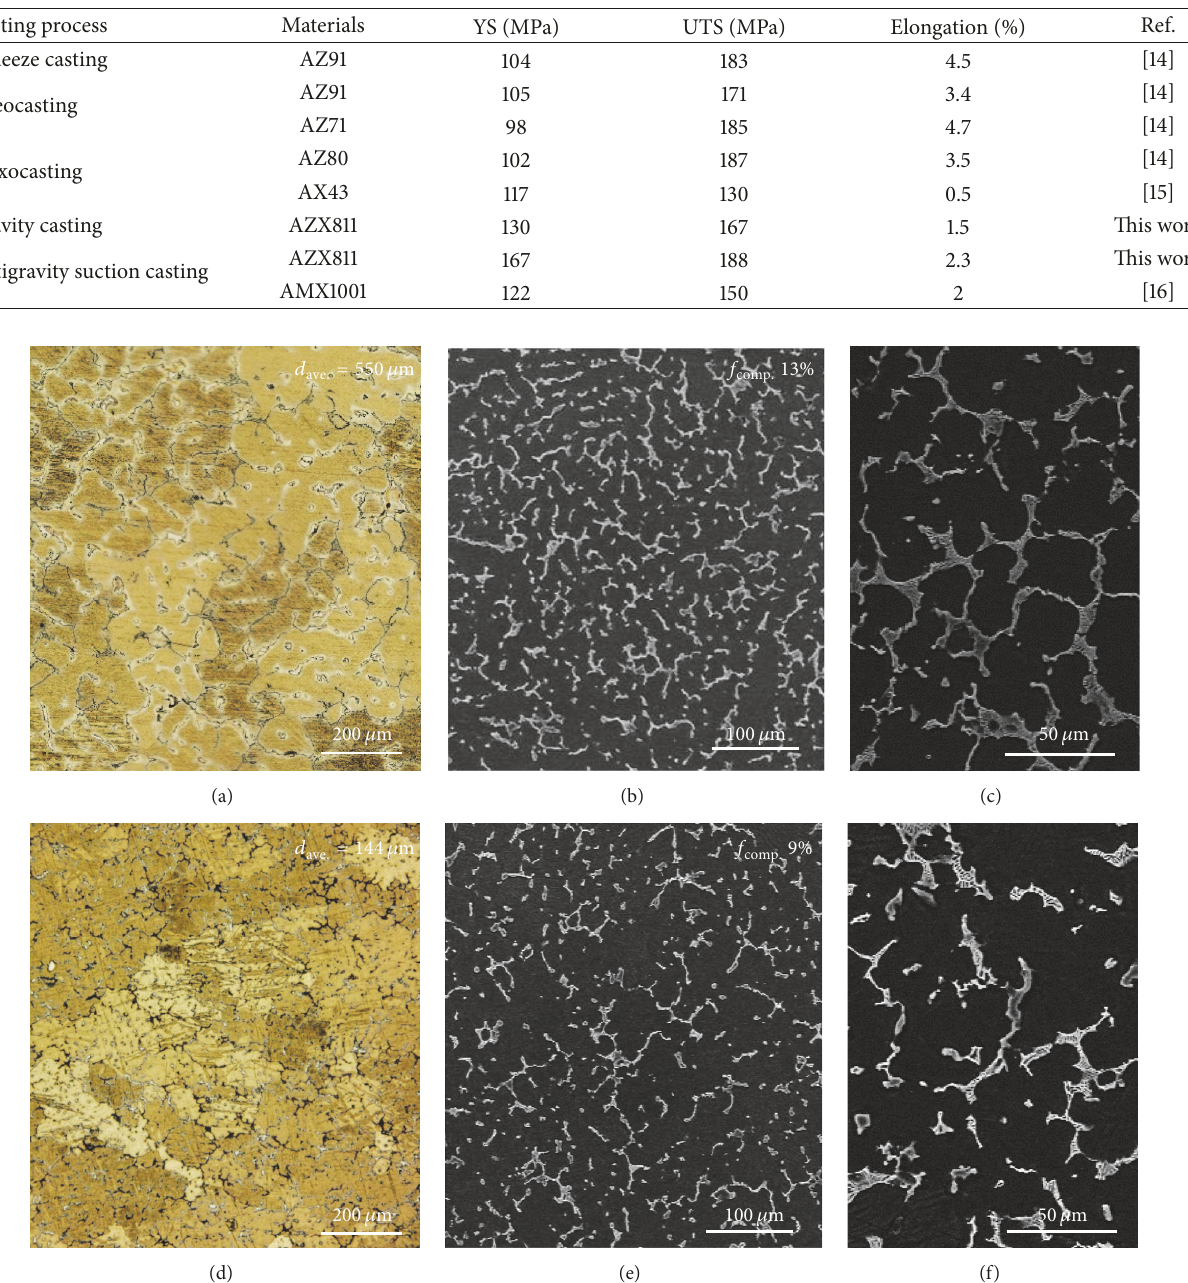
Table 2: Mechanical properties of several Mg cast alloys.